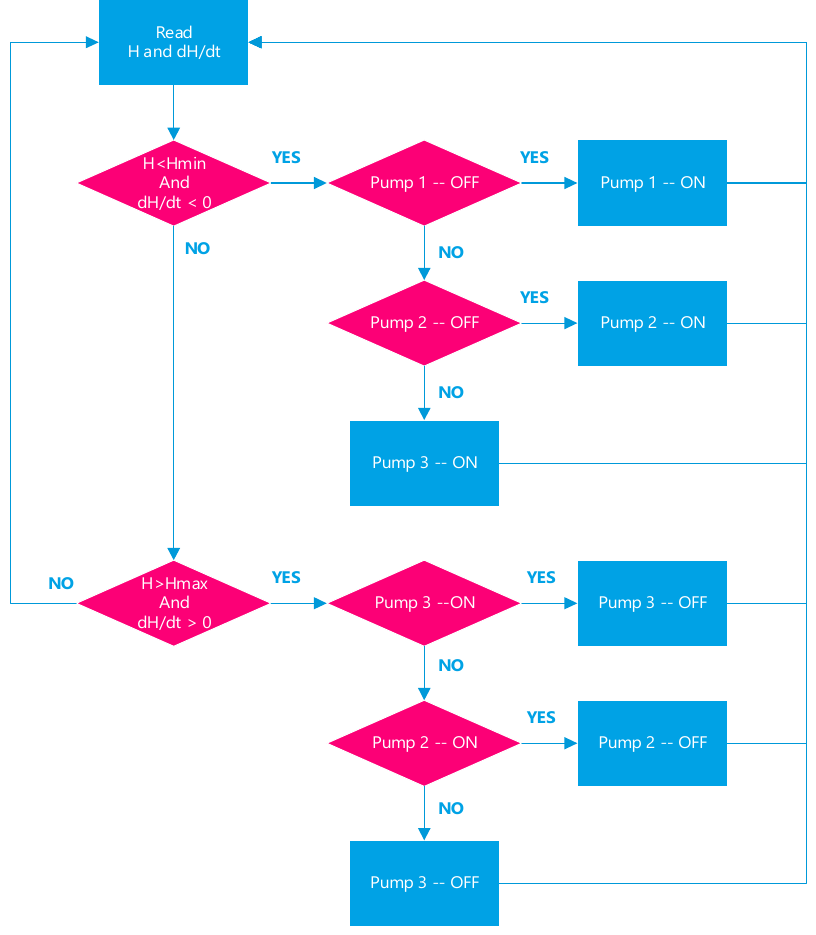
Figure 6. Control logic of auxiliary water pump (A. Malekpour).